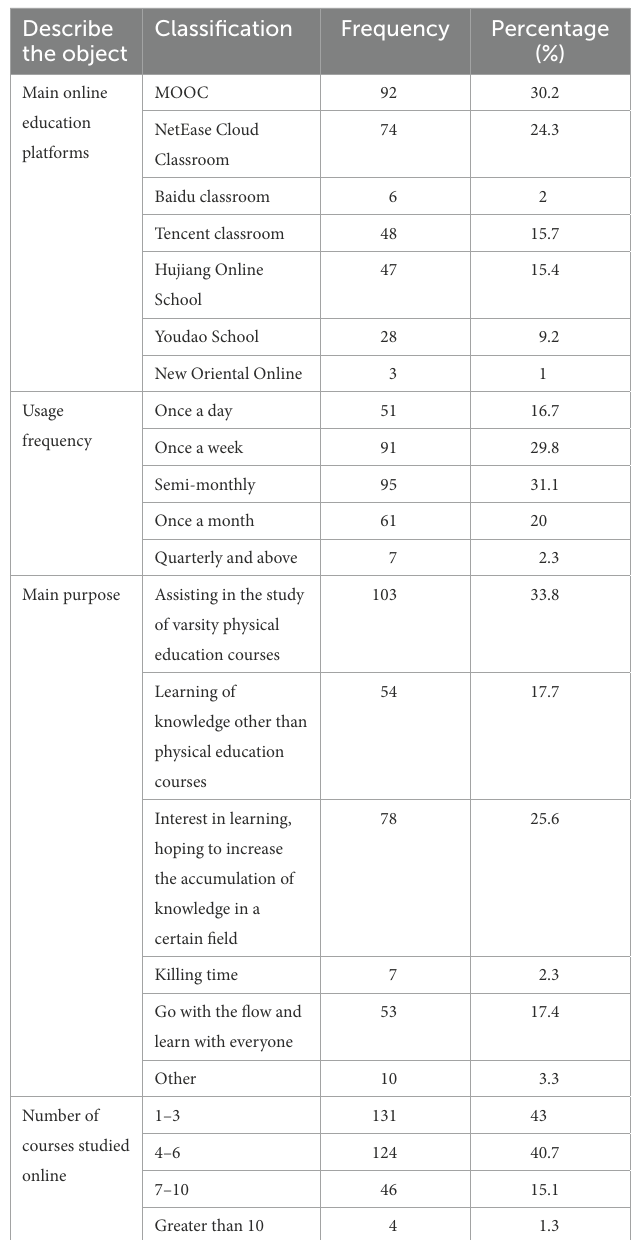
TABLE 2 Main results of the questionnaire.